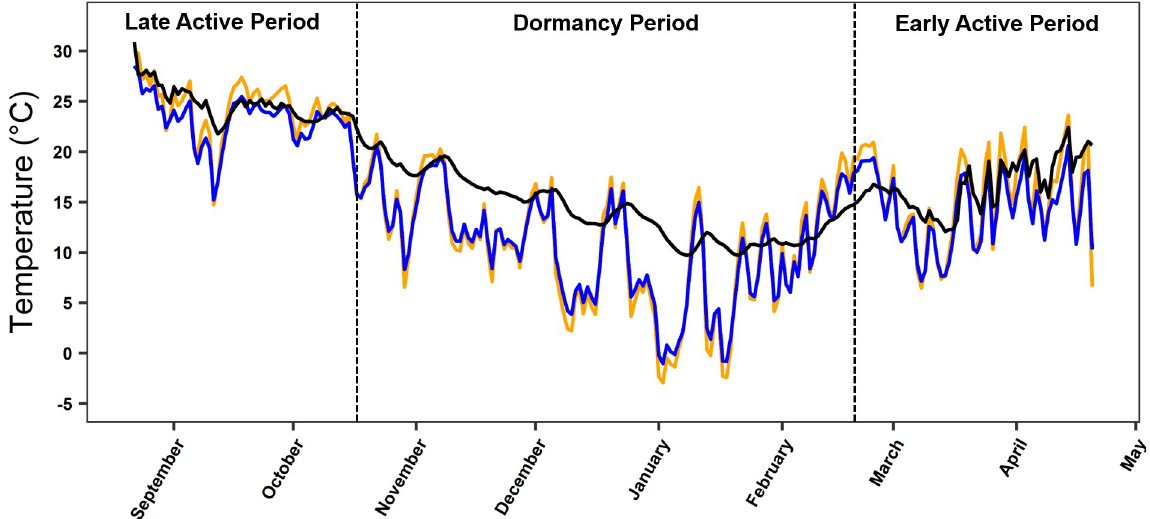
Fig 3. Mean daily tegu ( Salvator merianae ) body temperature in comparison to mean daily air temperatures. Mean daily body temperature of tegus (T b , solid black line; N = 11 internally-implanted micro dataloggers) and mean daily air temperature of micro dataloggers in shaded areas (blue line, N = 11) and unshaded areas (orange line; N = 11). The two vertical dotted lines define activity periods.